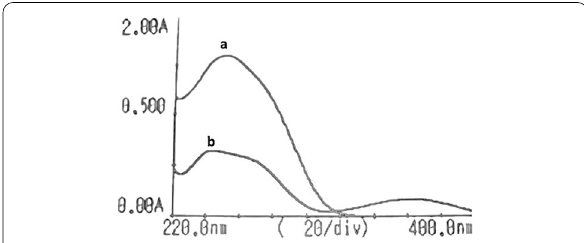
Fig. 2 Overlay absorbance spectra of a atorvastatin (20 µg/mL) and b amlodipine (7.5 µg/mL) in 50% aqueous